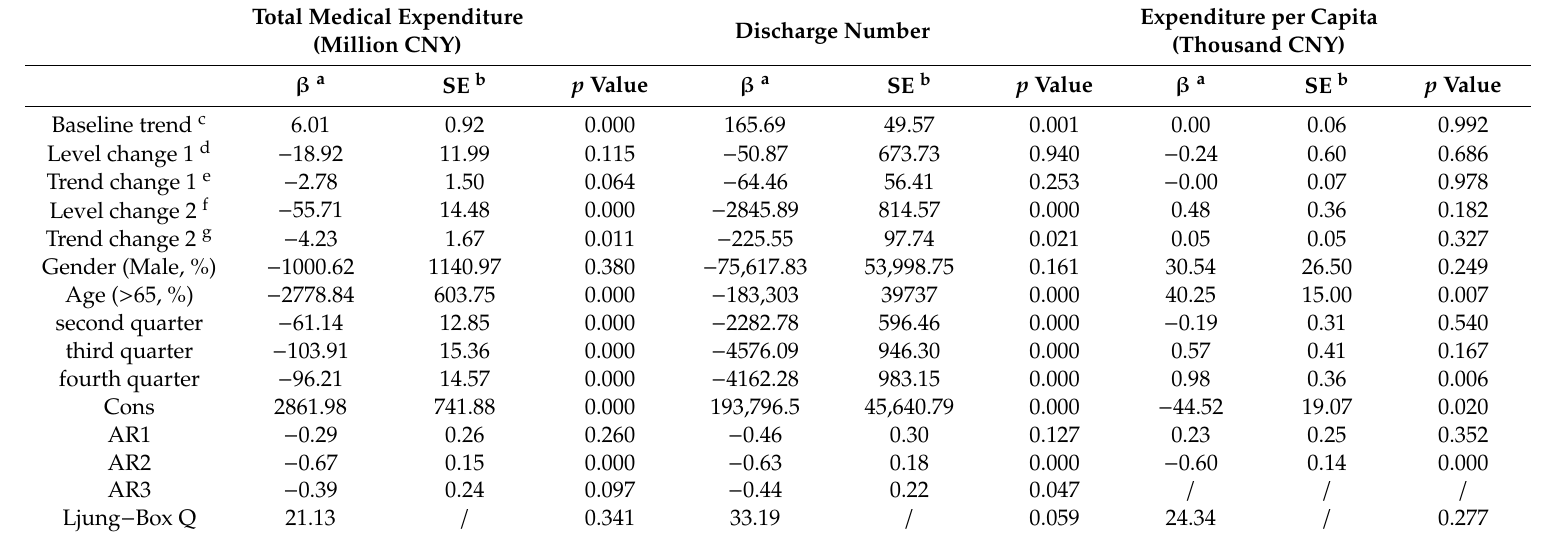
Table 2. Segmented autoregressive integrated moving average analysis of medical